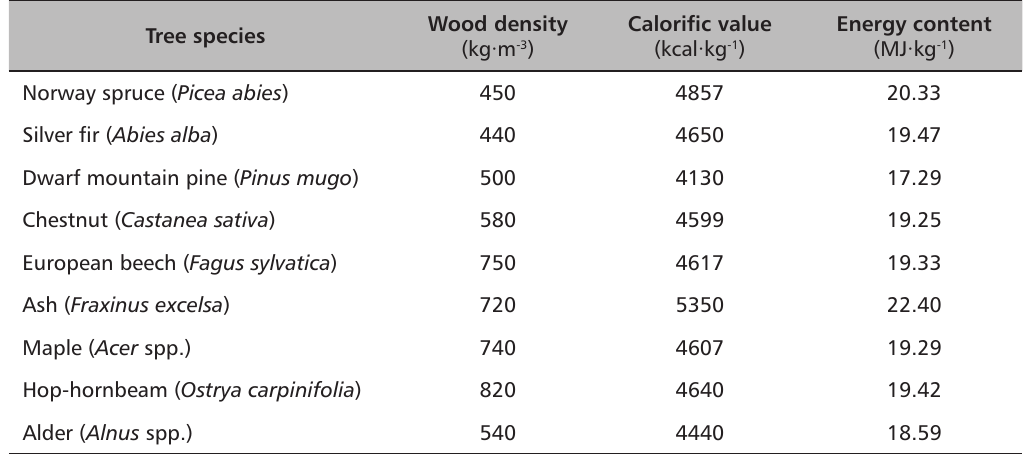
TABle 4. Energy content of main tree species present in the case studies Tree species